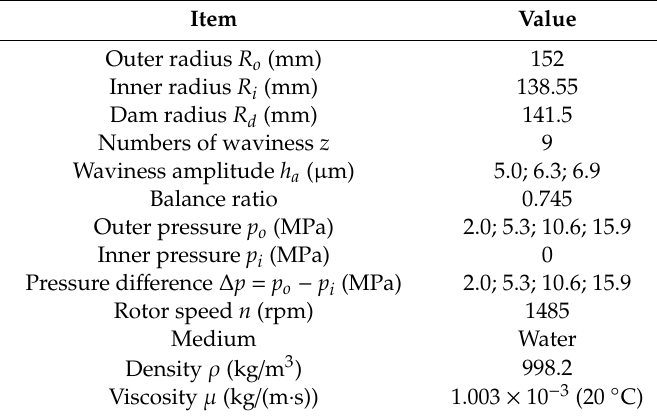
Table 1. Geometric and operating parameters.